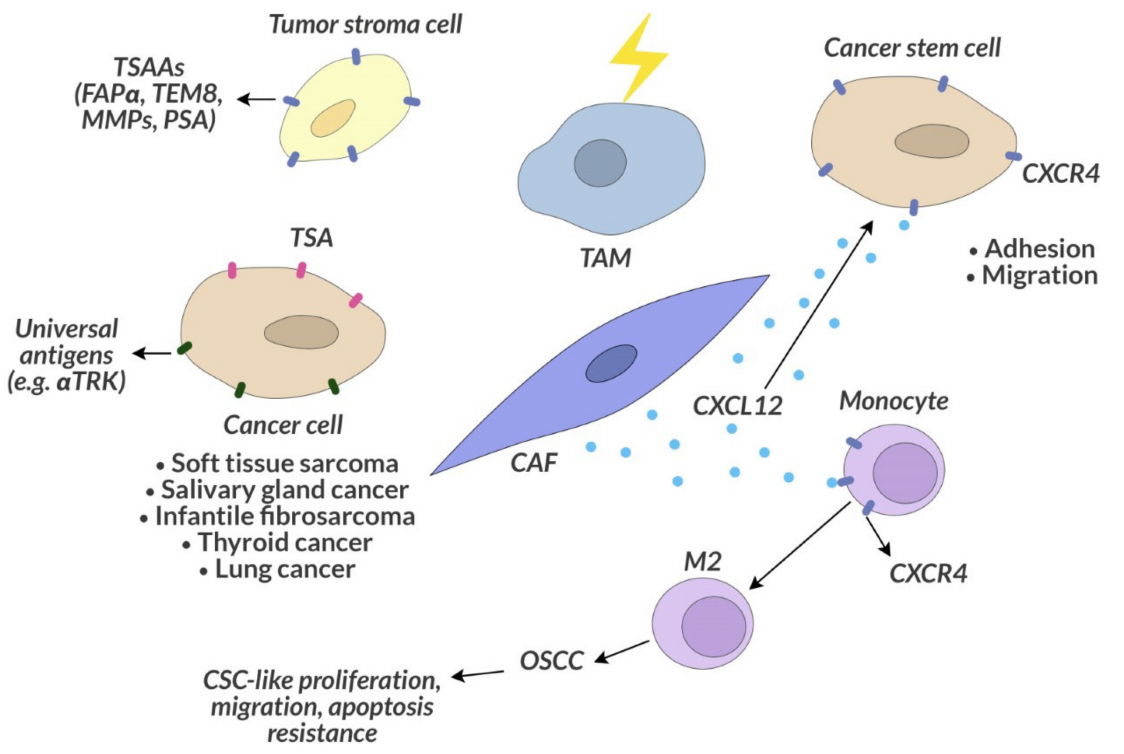
Figure 5. Diagram showing potential therapeutic targets on cancer cells. TSA—Tumor-specific antigen, TSAAs—Tumor Stroma-Associated Antigens, FAP α —Fibroblast activation protein α , MMPs—Matrix metalloproteinases, TEM 8—Tumor endothelial marker 8, PSMA—Prostate-specific membrane antigen, TRK—tyrosine kinase, TAM—Tumor-associated macrophage, CAF—Cancer-associated fibroblast, M2—Macrophage 2, CXCL12—C-X-C motif chemokine 12, CXCR4— chemokine receptor for CXCL12, OSCC—Oral squamous cell carcinoma, CSC-like—Cancer stem-like